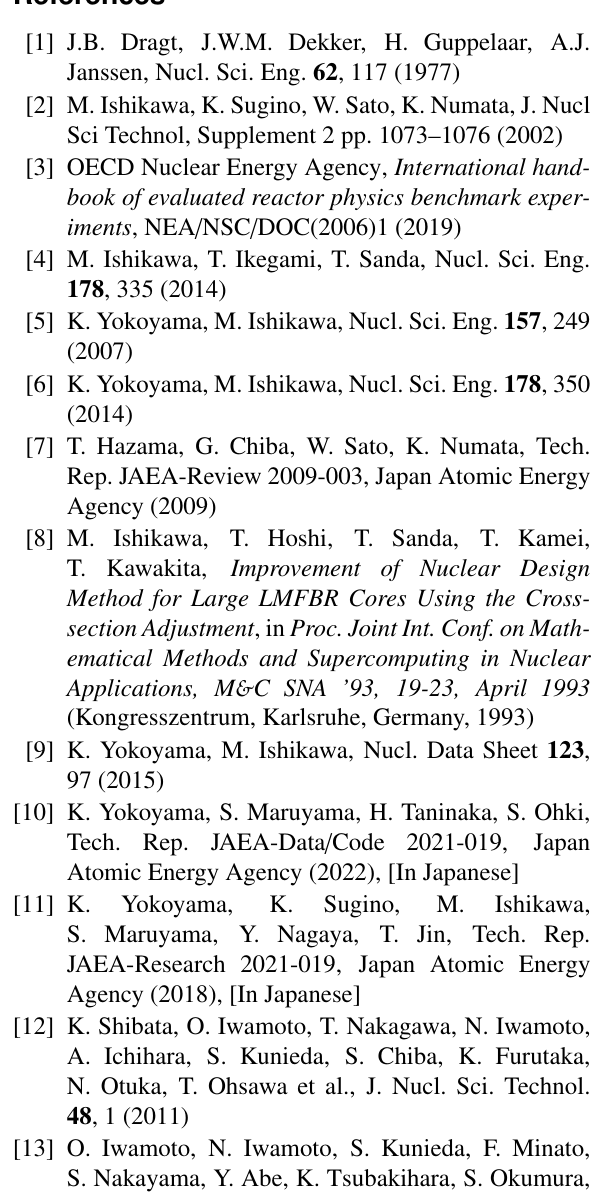
Figure 8. Nuclear-data-induced uncertainty of sodium void re-